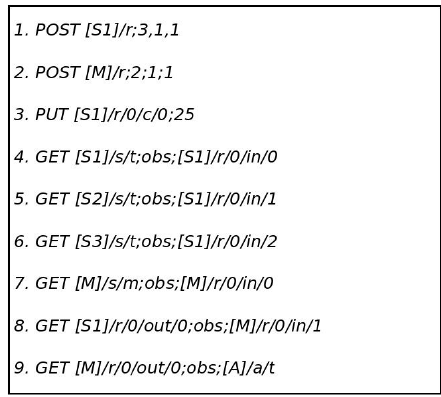
Figure 9. RESTlet block diagram for the smart home scenario.